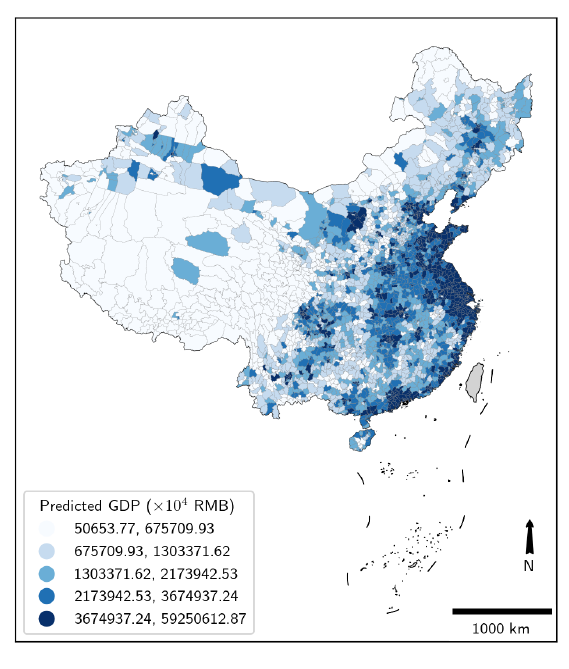
Figure 5. Spatial distribution of the predicted GDP values.